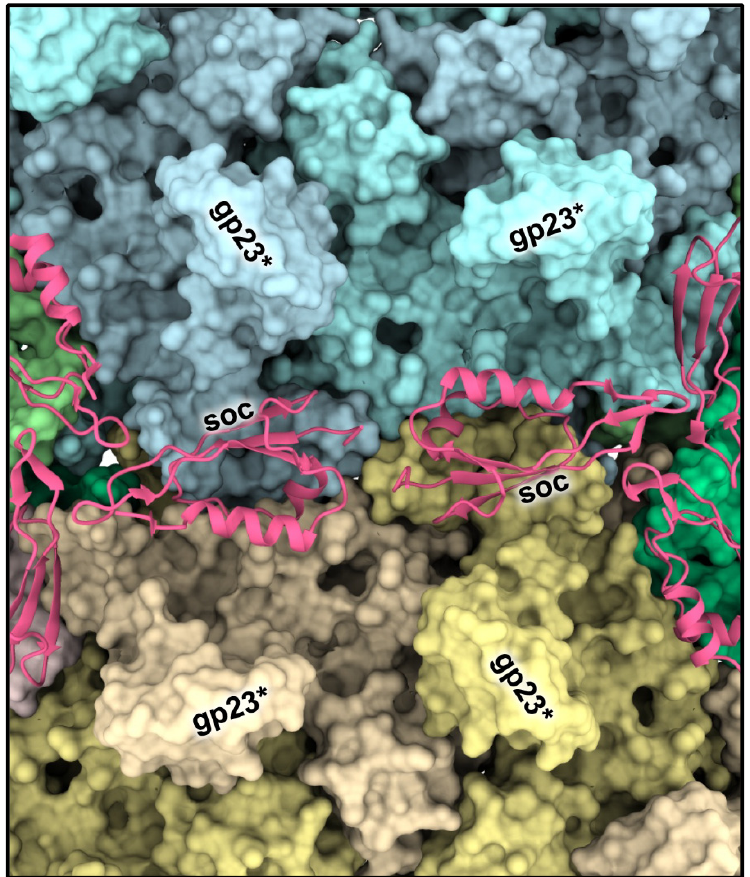
Figure 4. Soc molecules clamp the capsomers of the mature expanded T4 head. Each Soc subunit (shown as a ribbon diagram in magenta) interacts with two neighboring gp23* capsomers (shown as surfaces in various colors) reinforcing the capsid structure (PDB ID: 5VF3).